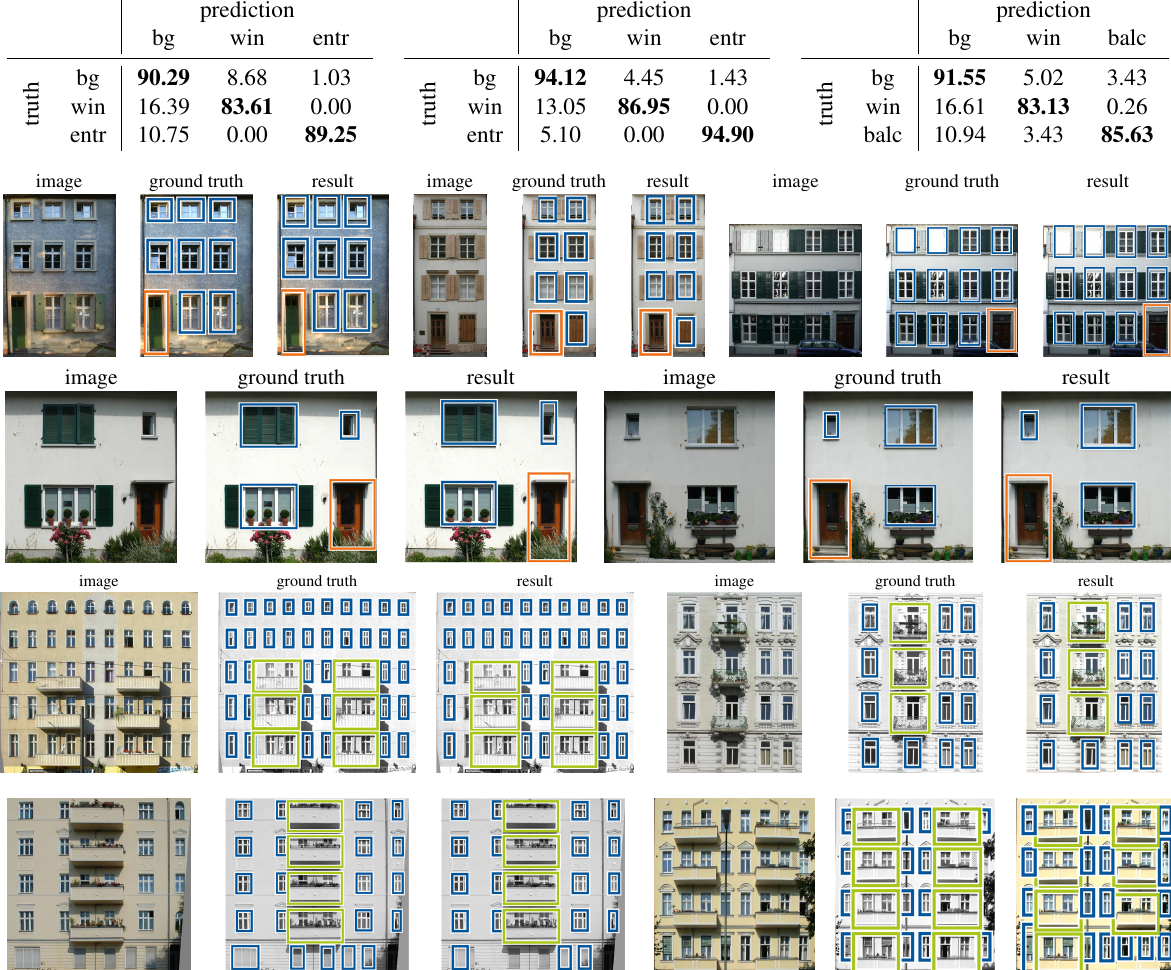
Table 1: Confusion matrices for for pixelwise evaluation. Numbers are given as percentage of pixels that belong to the according class. Left: Basel old town. Middle: Basel row houses. Right: City houses with balconies.